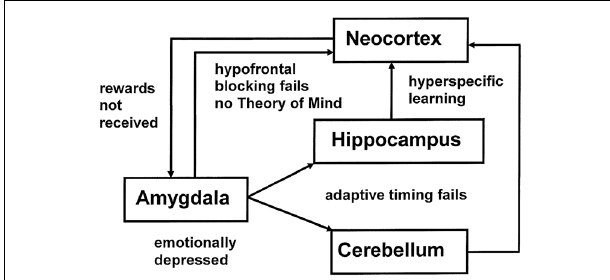
FIGURE 1 | The imbalances in the iSTART model of Grossberg and Seidman (2006) that contribute to autistic behavioral symptoms are: hypervigilance in brain regions like nonspecific thalamus and hippocampus leading to learning of hyperconcrete recognition categories and a narrow focus of attention by brain regions such as the temporal cortex; underarousal of value categories within brain regions such as the amygdala/hypothalamus, leading to elevated thresholds for emotional responsiveness, with the effect of insufficient incentive motivation to support prefrontal processing, but emotional hypersensitivity when these thresholds are exceeded, leading to coping behaviors to avoid these aversive emotions; and an absence of adaptive timing in brain regions such as the hippocampus and cerebellum, leading to attentional distractibility and premature release of actions that typically require delayed activation in order to be socially appropriate. Experimental data that are explained and predicted by these mechanisms are reviewed in Grossberg and Seidman